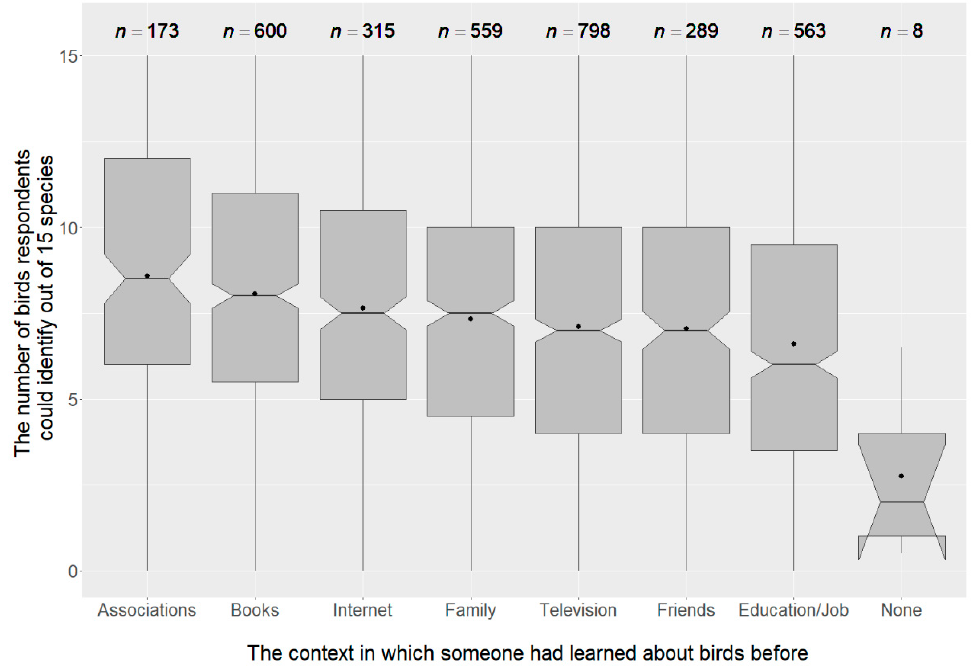
Figure 2. Bird species knowledge on the identification test depending on the specified source of knowledge. Lower end of the boxplot shows the first quartile, the median is indicated by a line in the notch (95% confidence interval of the median) and the 75% quartile is marked by the upper end of the boxplot. The dot within the boxplot indicates the mean score.